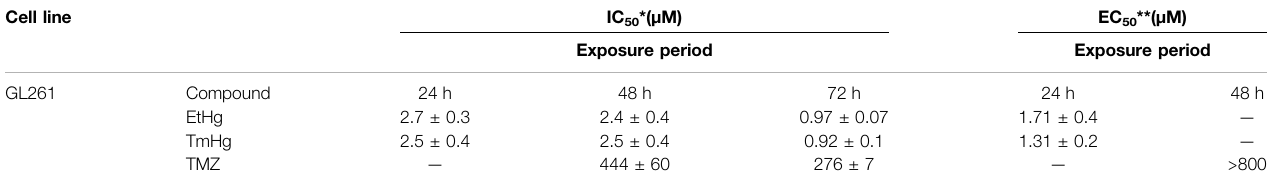
TABLE 1 | Effects of TmHg, EtHg, and TMZ on GL261 and viability and death. All the determinations were performed three or more times in independent experiments. Cell line